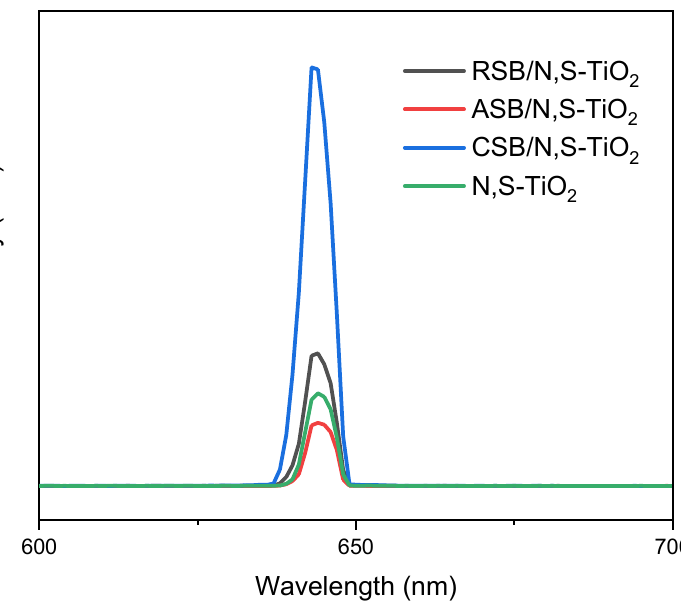
Figure 4. Photoluminescence of N,S-TiO 2 and three composite materials.